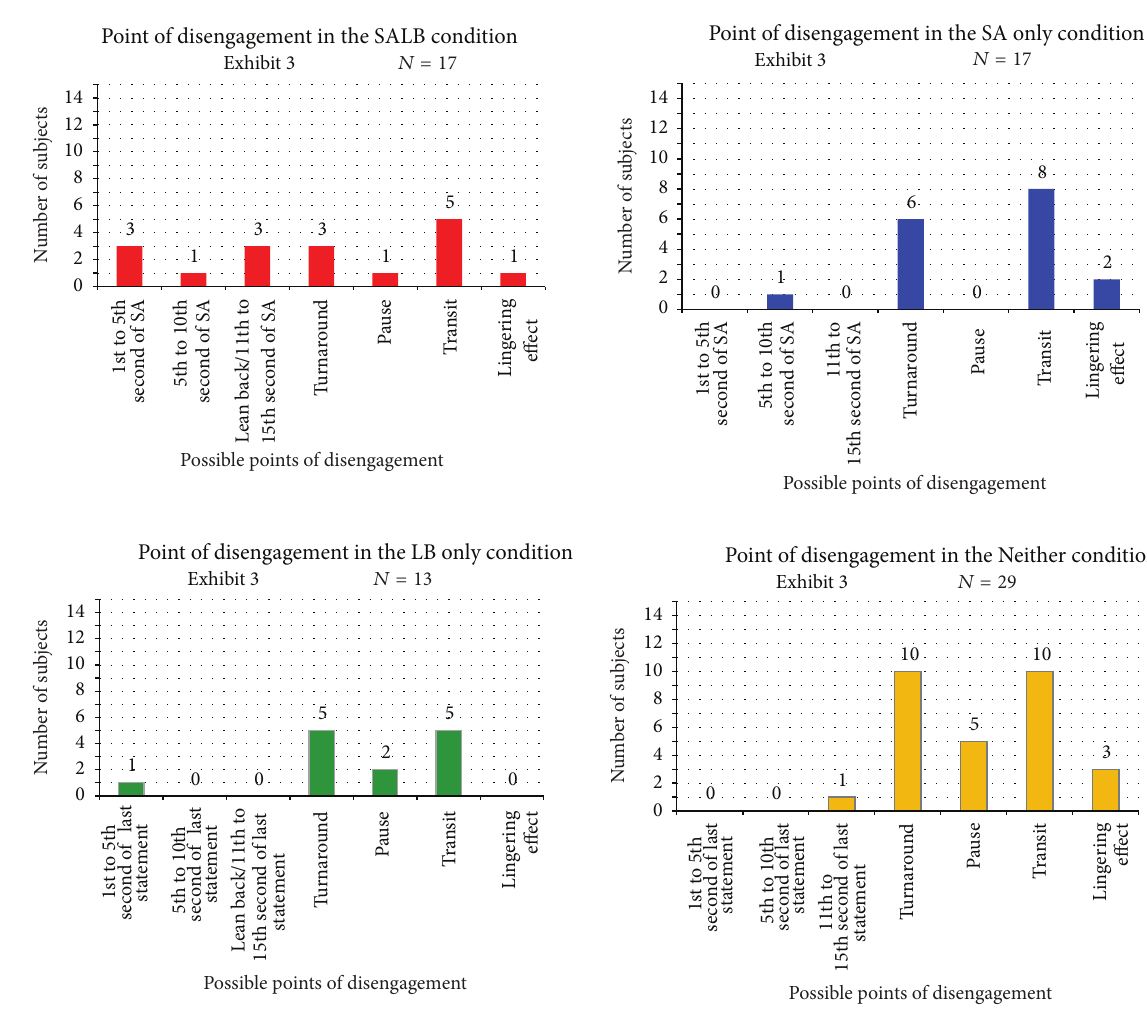
Figure 12: Points of disengagement in the four conditions at exhibit 3.